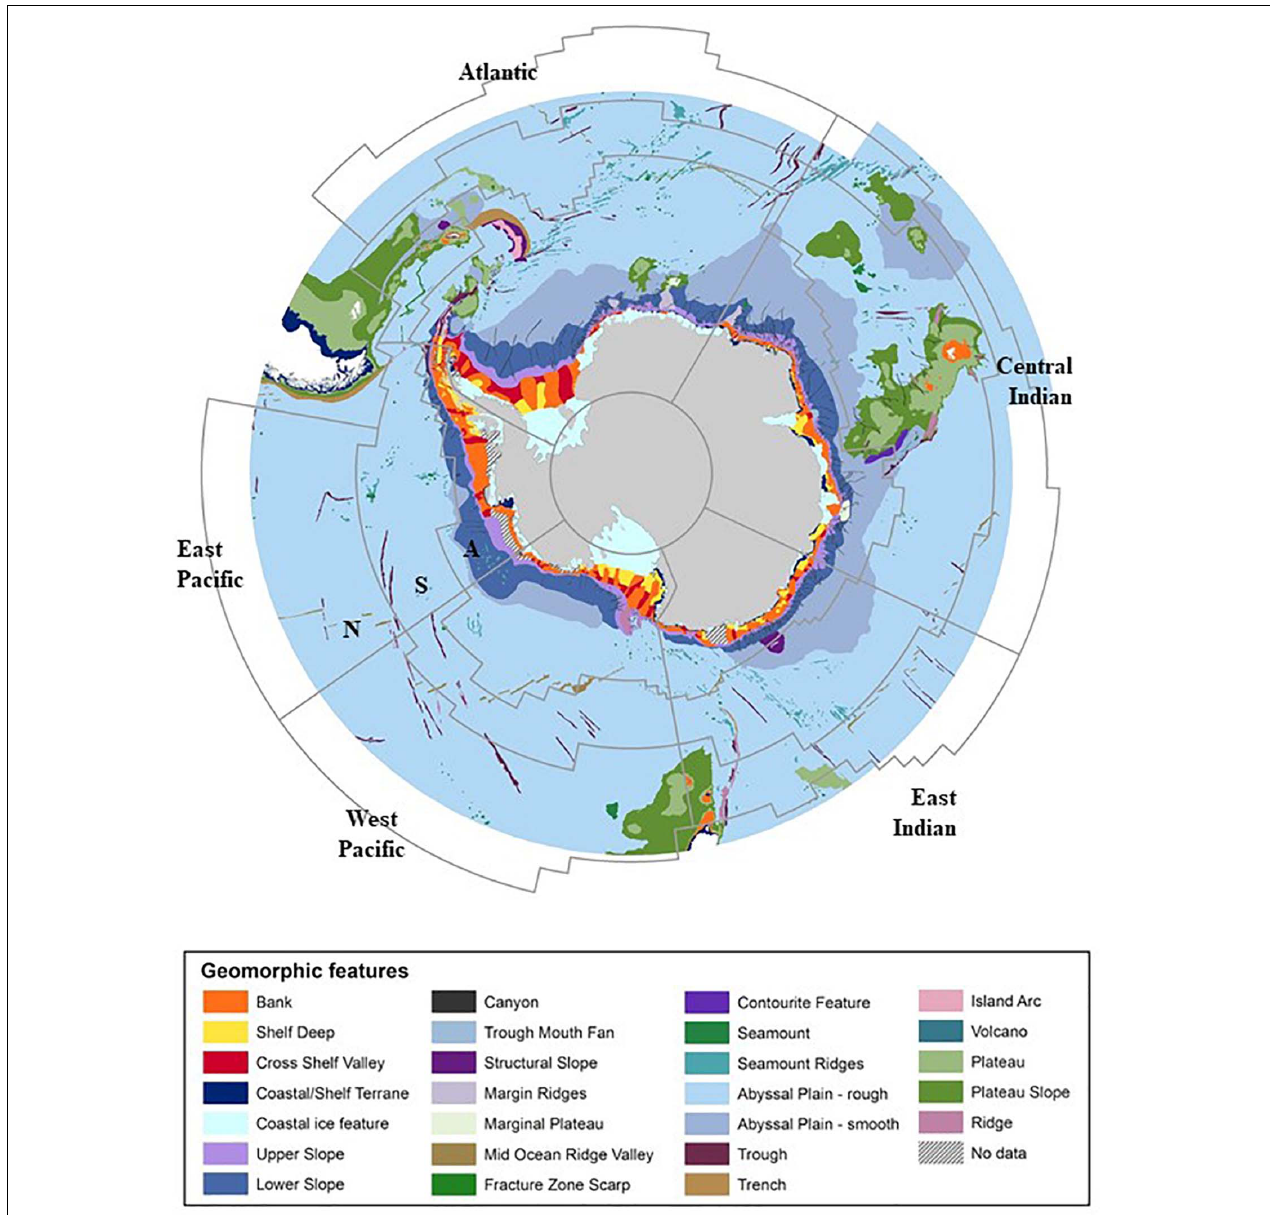
FIGURE 3 | Geomorphic features of the Southern Ocean. MEASO areas are shown (thin gray lines) including MEASO sectors (Atlantic, Central Indian, East Indian, West Pacific, East Pacific) and MEASO zones (where N = northern, S = subantarctic, A = Antarctic). Data adapted from O’Brien et al. (2009); Post et al. (2014), definitions of geomorphic features are provided in Supplementary Information